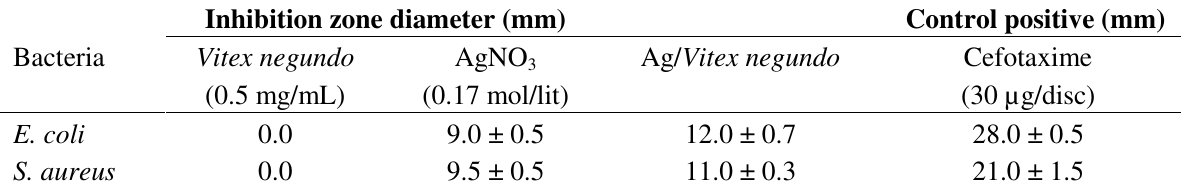
Table 1. Average of inhibition zones synthesized Ag/ Vitex negundo nanoparticles.